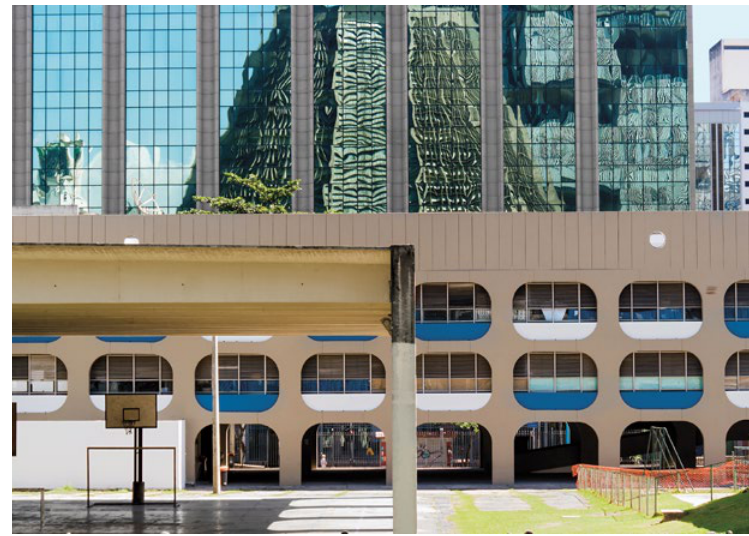
Figure 3 CIEP José Pedro Varela in Lapa: the pudding-shaped Catedral de São Sebastião is reflected in the glazed office block behind the school. Image © Aberrant Architecture.